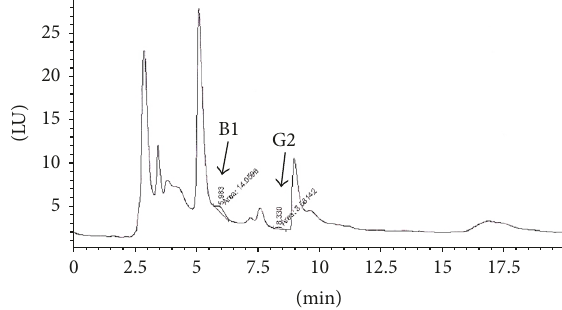
Figure 6: Concentration of total AFs in branded and local samples of